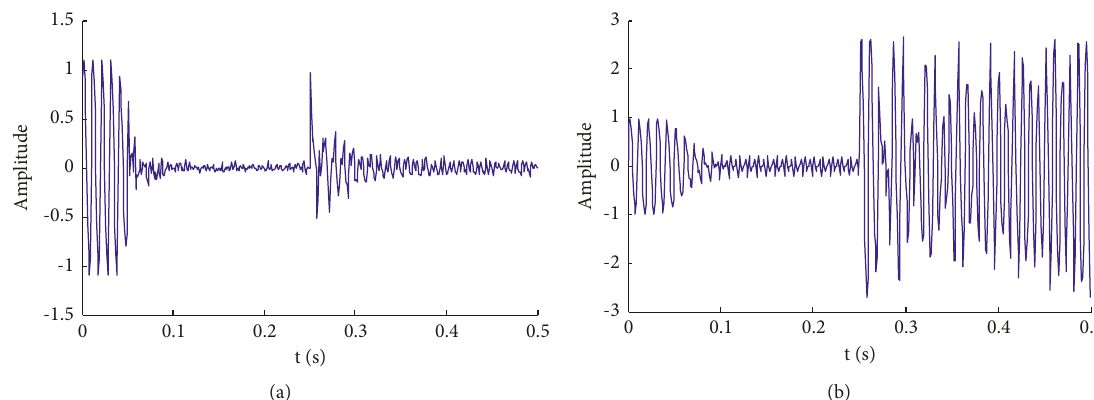
Figure 7: The curve of error signal changing with time in the improved algorithm. (a) Reference signal is doubled at 0.25 seconds. (b) Reference signal is quadrupled at 0.25 seconds.